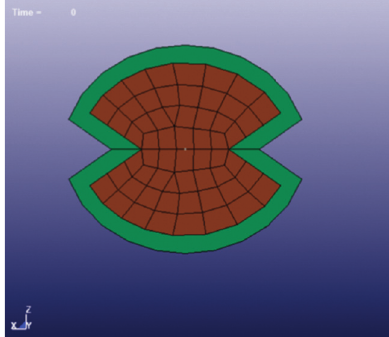
Figure 7: Geometric model of the condenser tube.